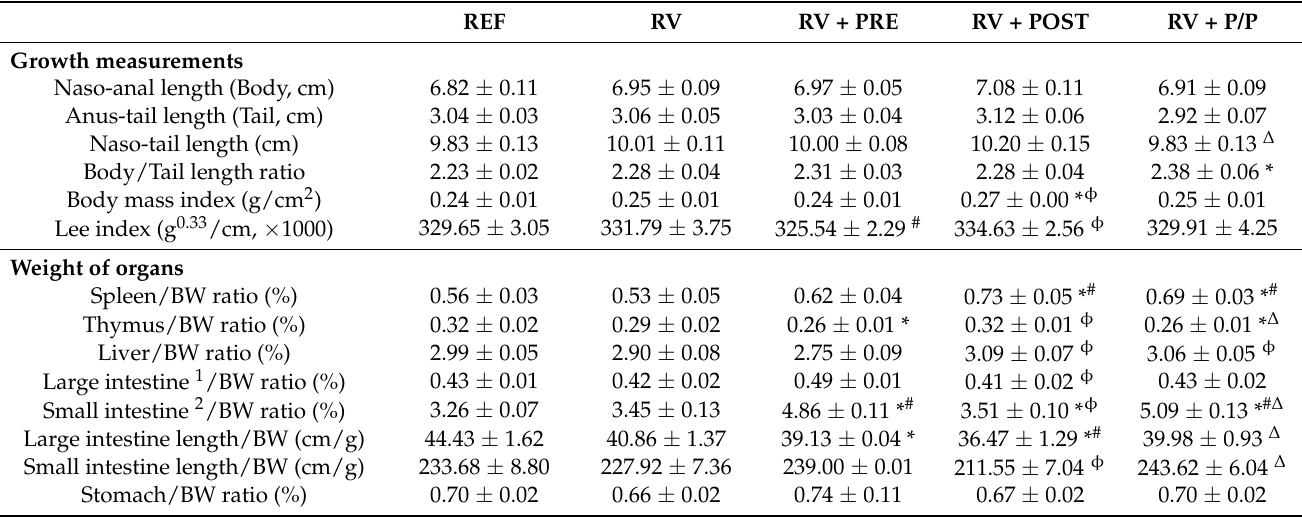
Table 1. Growth-associated measurements and weight of organs, normalized by body weight (BW) at the peak of diarrhea (day 8 of